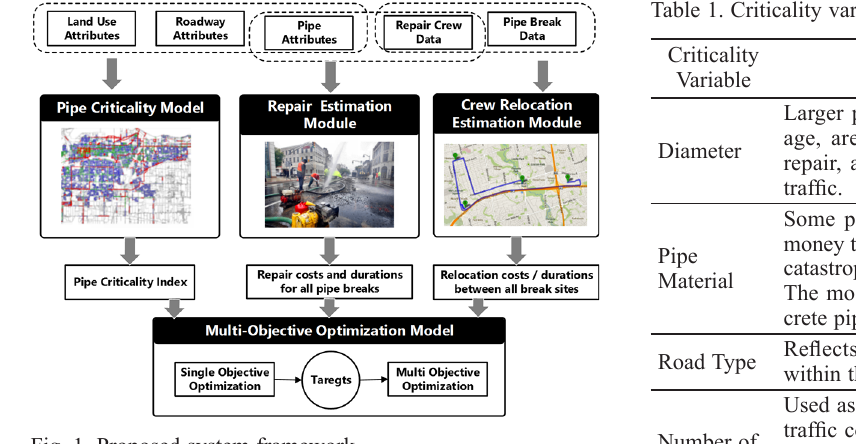
Fig. 1. Proposed system framework